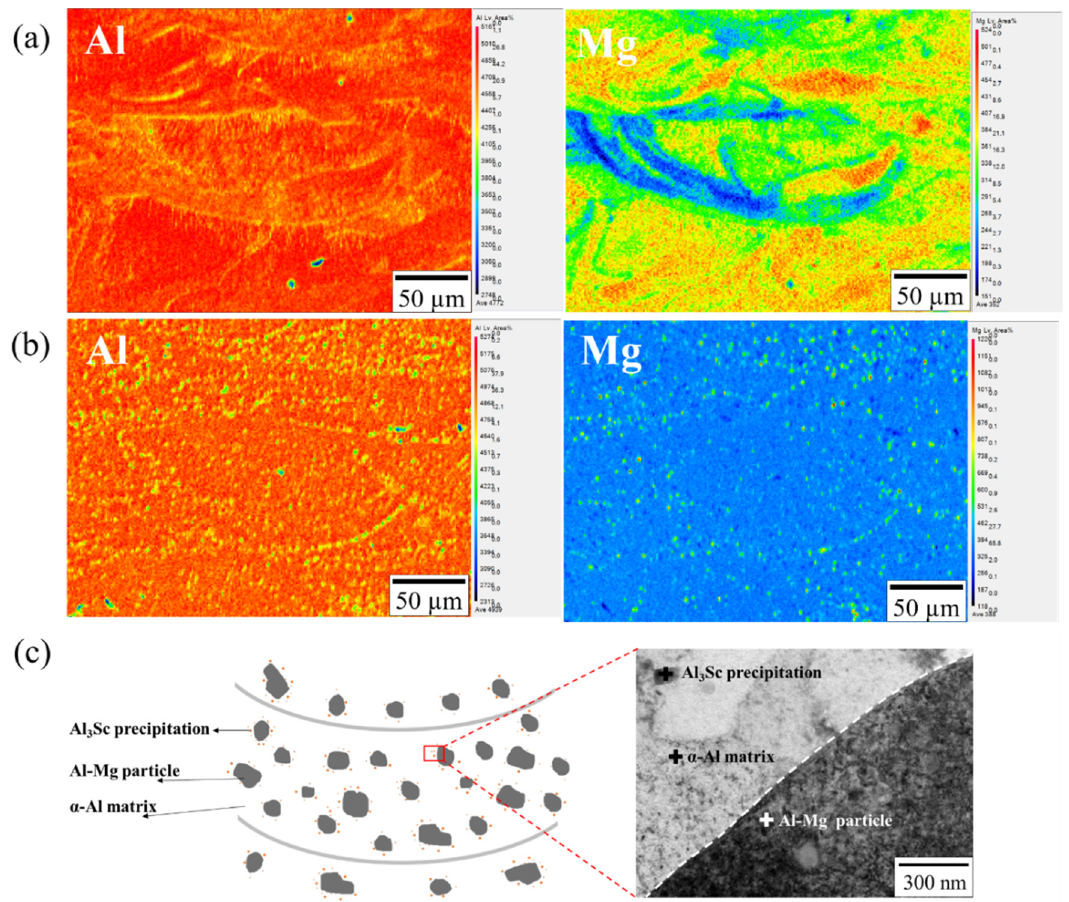
Figure 11. ( a ) EPMA image (Al and Mg elements) of the as-printed specimen; ( b ) EPMA image (Al and Mg elements) of the two-stage-heat-treated specimen; ( c ) schematic diagram and TEM image of the two-stage-heat-treated specimens.